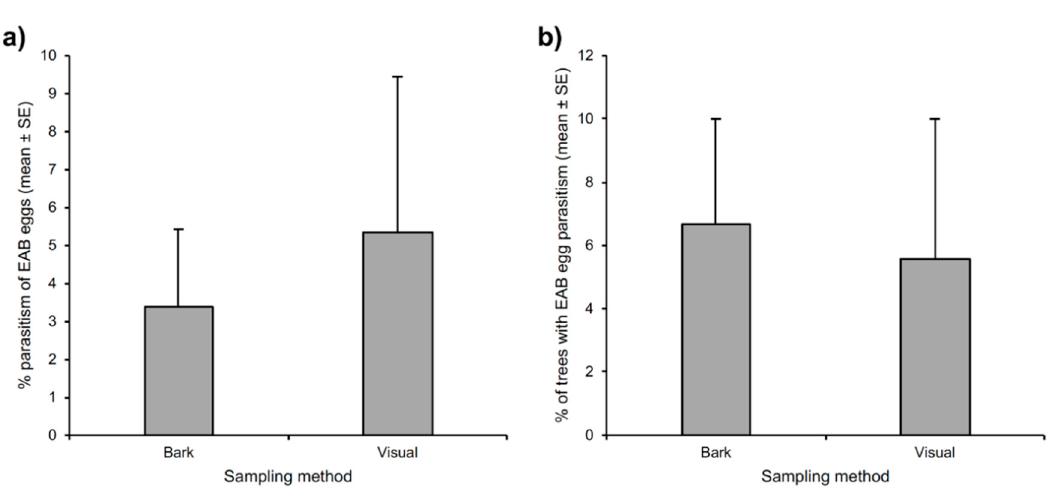
Figure 3. Comparison of results using visual survey and bark sifting methods. Shown are percent parasitism ( a ), and percentage of trees with parasitized emerald ash borer eggs ( b ), across the nine recovery sites. Black lines represent standard error.